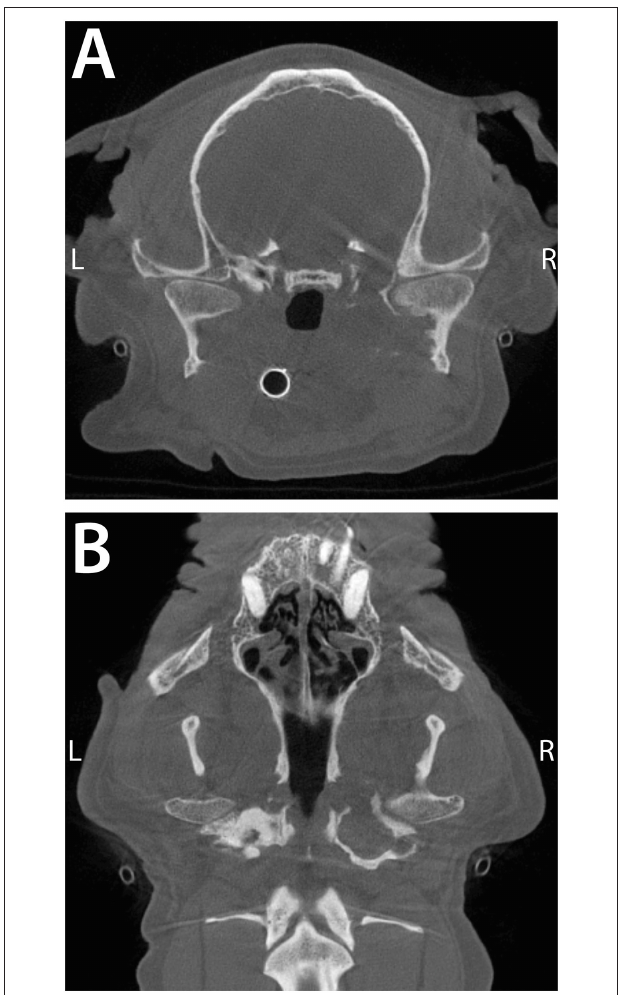
FIGURE 6 | Transverse (A) and dorsal (B) CBCT images of a 11-year-old, dog described in Case 4. Note the severe periosteal reaction at the medial aspect of the right condylar process and the engulfment of the medial aspect of the TMJ by the deformed bulla. The intimate proximity of the middle ear to the TMJ provides a readily available source for infection to the